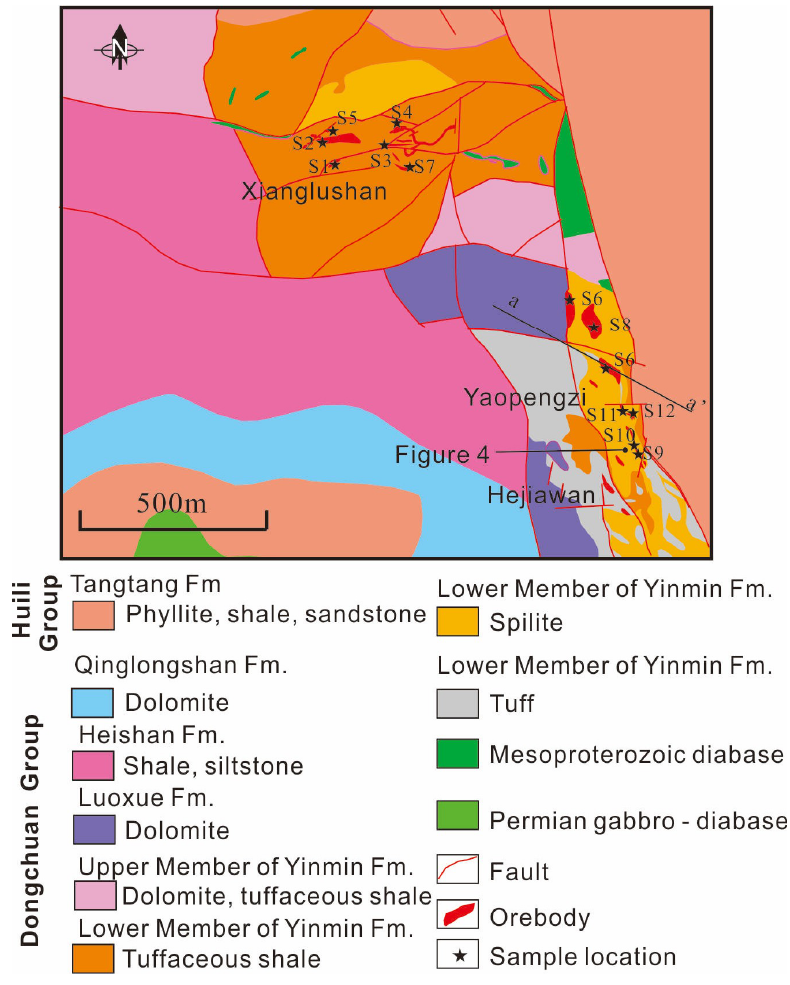
Figure 3. Geologic map of the Xianglushan